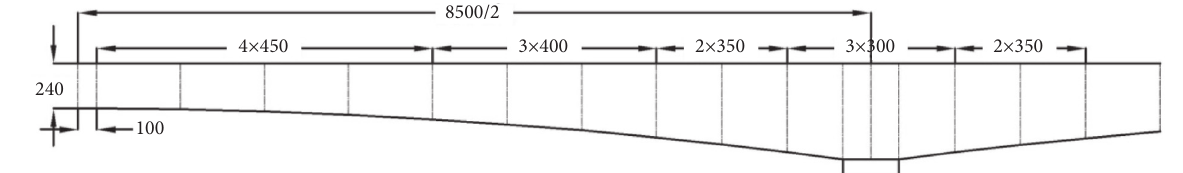
Figure 2: Elevation view of the middle span girder (dimension units: